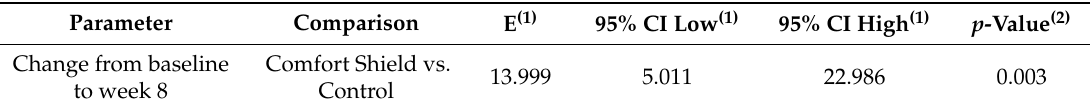
Table 10. Vision OSDI subscore: Multivariate analysis on change from baseline to week 8—mixed-e ff ects model for repeated measures—PPS population ( n = 84)– n used = 84. Parameter Comfort Shield vs.